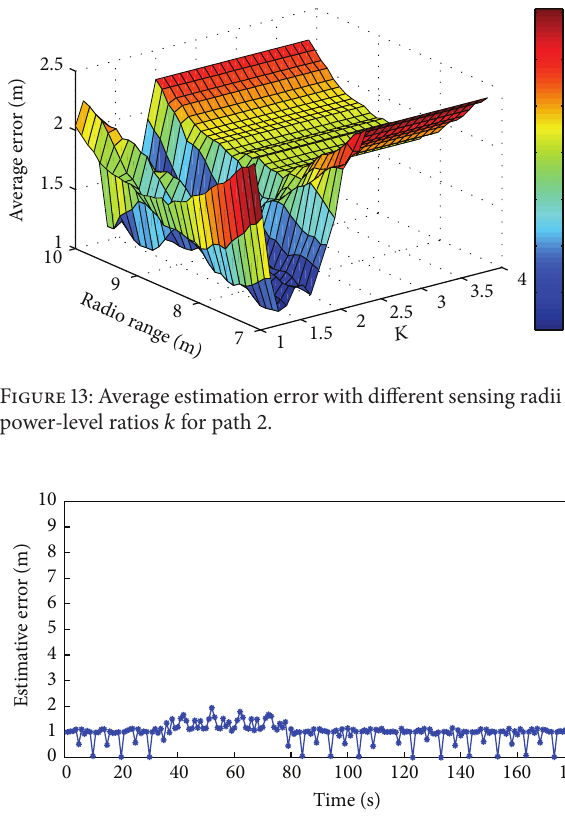
Figure 14: The location estimation error with shadowing model for path 1